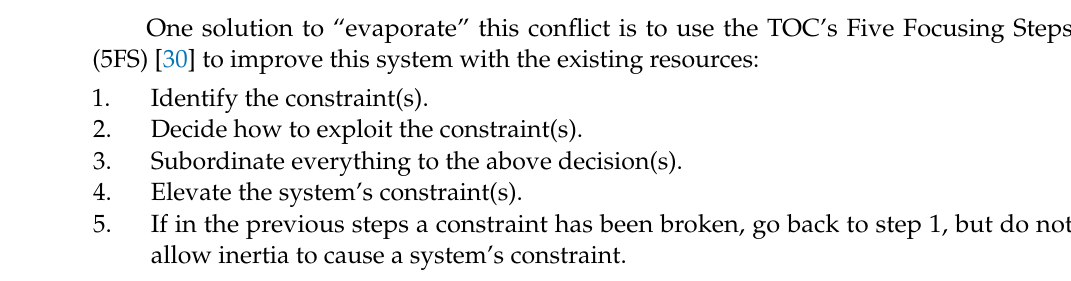
Figure 3. Evaporating clouds illustrating a real-life healthcare example ( a ) and the game ( b ). An explanation about the cloud is at the bottom.